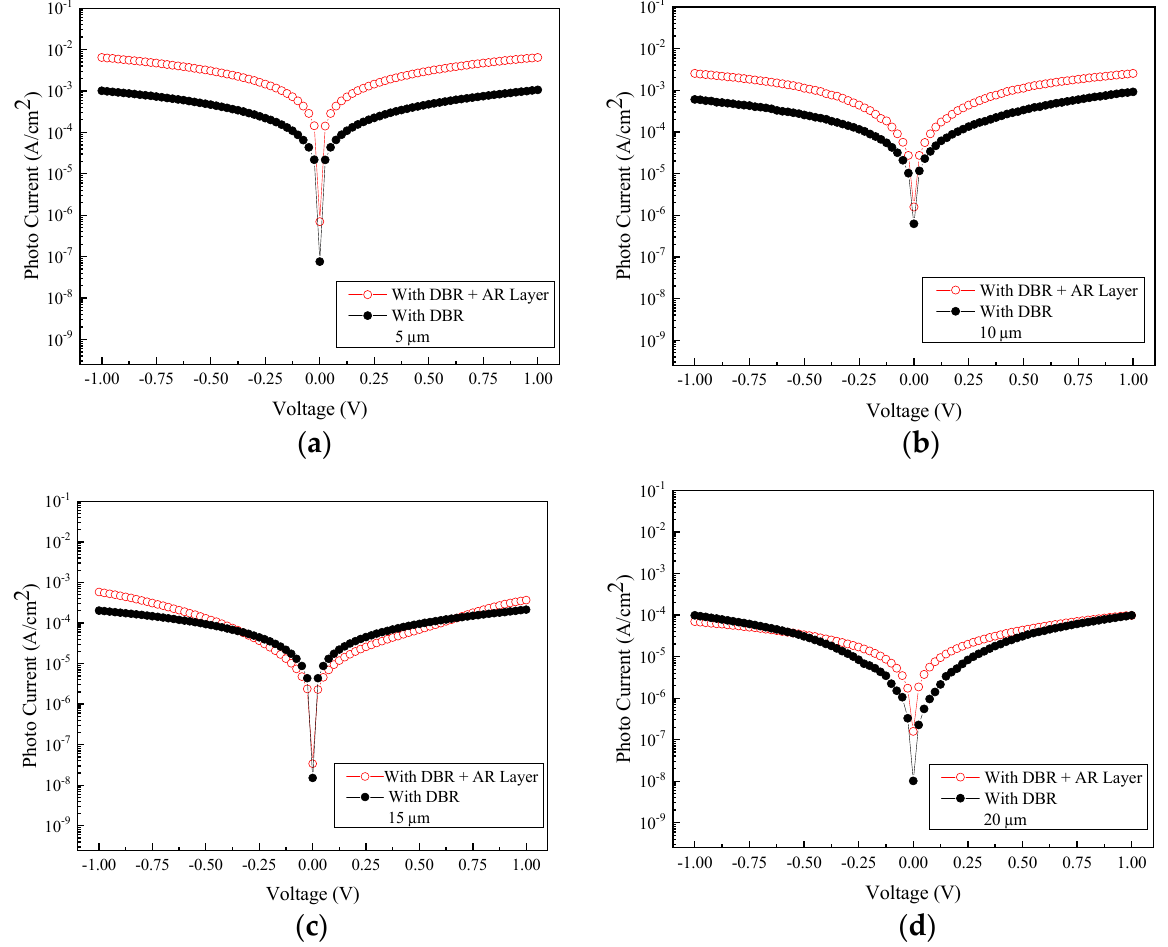
Figure 17. Comparison of photocurrents recorded before and after introducing the AR layers to the samples of different electrode sizes: ( a ) 5 µm, ( b ) 10 µm, ( c ) 15 µm, and ( d ) 20 µm. The normalized spectral responsivity is displayed in Figure 18. The photodetector exhibits responsivity at NIR (1800 to 2100 nm) with a sharp downfall beyond 1950–2000 nm, which is correlated to the absorption edge and bandgap of GeSn. Since the cutoff wave- length of Ge falls between 1550 and 1800 nm, alloying 8% Sn with Ge extends the absorption of our Ge 0.94 Sn 0.06 samples to the near NIR or close to 2000 nm wavelength, which has been empirically confirmed by the spectral responsivity measurement. To compare our results with other research teams’ published works based on the criteria of the metal- semiconductor-metal (MSM) and single GeSn absorption layer configurations, the 9% Sn-based MSM photodetectors fabricated by Son et al. earlier have managed to deliver the responsivities of 0.5 and 0.29 A/W at a wavelength of 1600 and 2033 nm at 2 V, respec- tively [25]. It appears that the highest responsivity (~1.3 A/W) achievable through our 8% Sn-based device with DBR and AR both included has an edge at a wavelength of 2000 nm and a bias voltage of 1 V. Furthermore, Ghosh et al. have realized a wide bandwidth in- frared detector with 4% Sn composition to cover a wavelength range of 1200 to 2100 nm [26]. The responsivity of their detector (in the mA/W level) peaks at the wavelength of 1200 nm and gradually dials down, and eventually levels off within a wavelength range of 1800 to 2100 nm when administering a bias voltage of 3 to 7 V. At 1 V, which is the voltage we have consistently used to characterize our detector’s responsivity at 2000 nm wavelength,